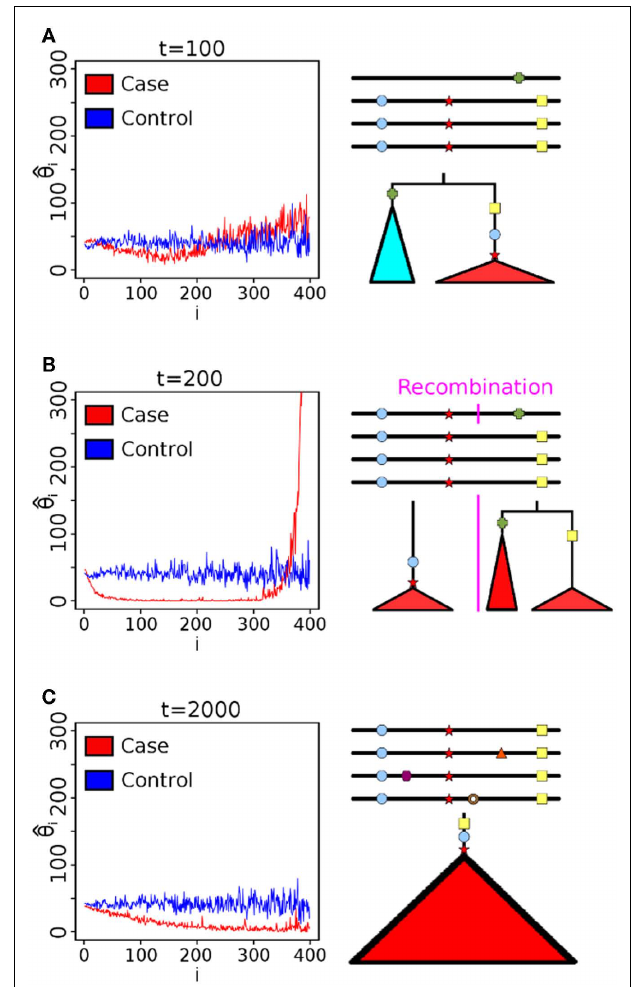
FIGURE 2 | SNP frequency spectrum analysis. Scaled allele frequencies ˆ θ = i ξ i i of simulated cases and control populations at different times after selection ( s = 0.08). Here, ξ i is the number of SNPs present in exactly i haplotypes.The ideal statistic is one that weighs alleles to maximize the separation between the blue and red line. (A) At t = 100, individuals with the beneficial mutation start to dominate the population (leading to a rise of high-frequency hitchhiking SNPs), but there is still a substantial fraction of individuals without the beneficial mutation. (B) At t = 200, many alleles that hitchhike with the beneficial mutation are near fixation, and the bulk of the mutations are very high frequency.Thus, measures that gives less weight to high-frequency alleles show high power. (C) At t = 2000, drift and recombination events decrease high-frequency alleles, while de novo mutations increase lower frequency.Thus, measures that weigh lower frequency alleles more rapidly lose power even with a clear signal between case and